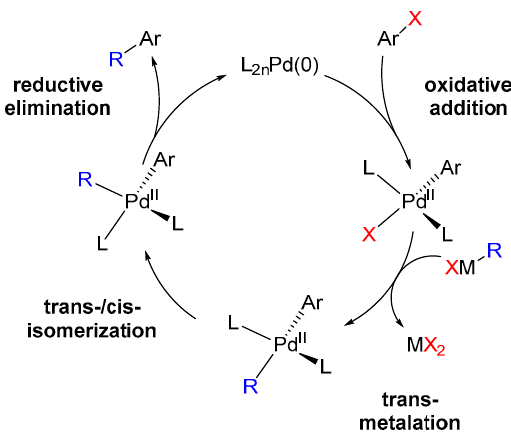
Figure 5. Scheme of the steps in cross-coupling reactions. After oxidative addition of the organo-halogen species, the transmetalation occurs. The ligands start rearrange before reductive elimination to the final product is carried out and the catalyst is regenerated.